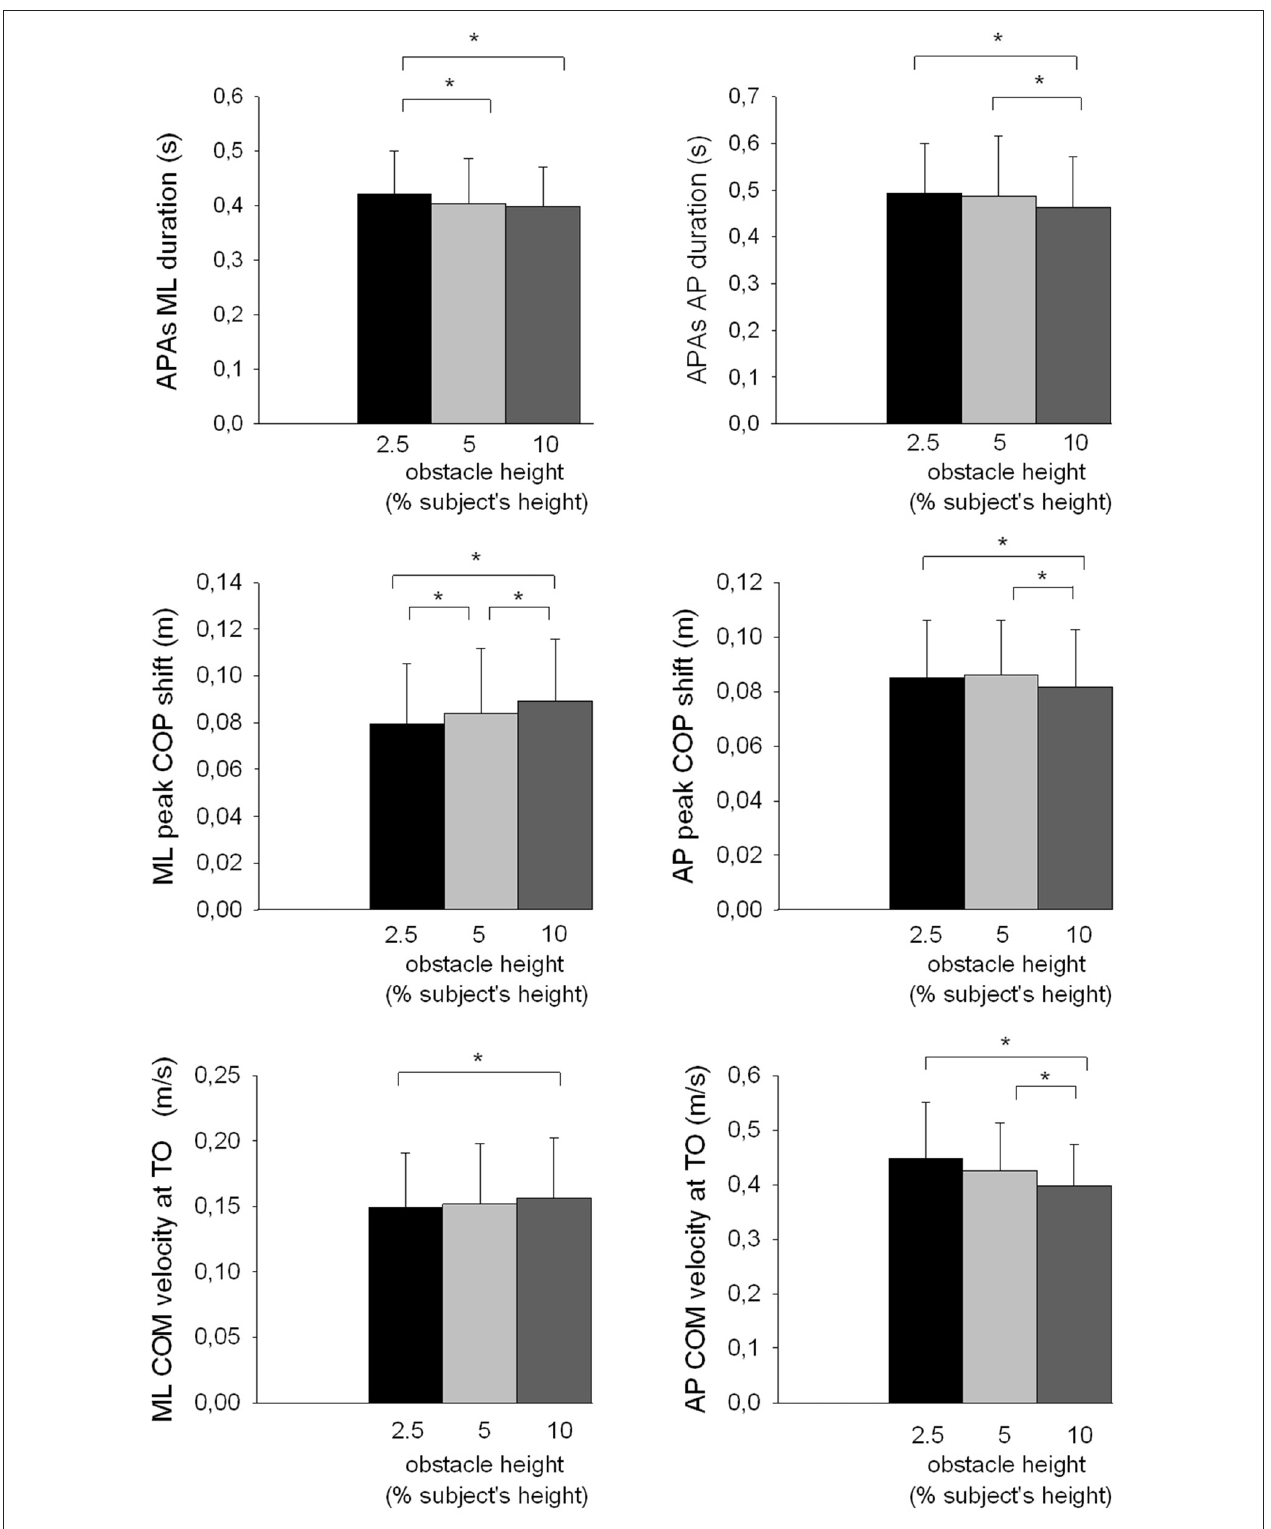
FIGURE 5 | Effects of obstacle height on selected ML and AP postural parameters. Reported are mean values (all participants together) ± 1 SD. APAs, anticipatory postural adjustments; TO, toe off; COP, center of pressure; COM, center of mass. ∗ Indicates a significant difference between bars.